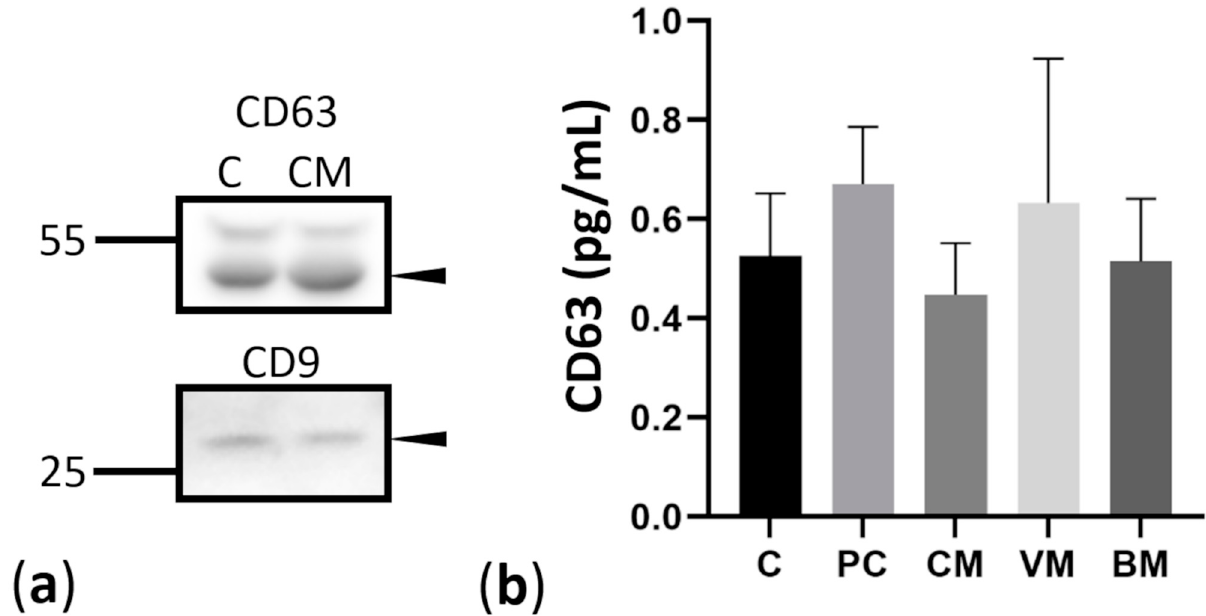
Figure 1. Assessment of exosomal markers. ( a ) Western blot analysis of exosomal markers CD63 and CD9. Arrows indicate the bands corresponding to CD63 (53 kDa) and CD9 (28 kDa), respectively, C—control, CM—cerebral metastases. ( b ) Estimation of exosome levels in patient serum. CD63 protein levels in exosomes from breast cancer patients with primary breast cancer (PC) and breast cancer patients with cerebral (CM), viszeral (VM), and bone (BM) metastases were estimated using a CD63-specific ELISA.